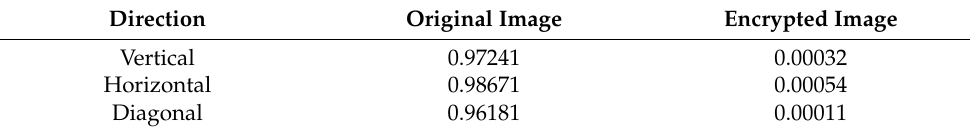
Table 3. Correlation coefficients of the original Lena image and its consistent encrypted